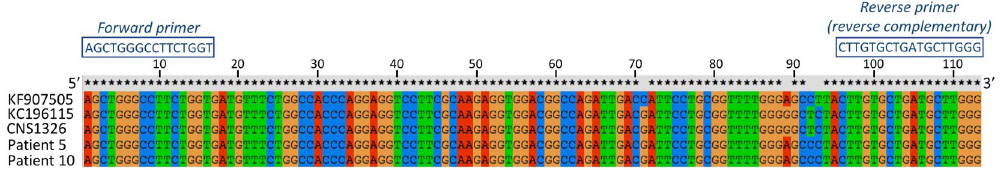
Figure 1. Sequences of the amplicons obtained by NS2A JEV RT-qPCR from throat swabs of patients 5 and 10. Sequences obtained for the 2 patients were aligned (using ClustalX 2.1) with the corresponding sequences of all JEV strains ever handled in the laboratory. KF907505: JEV RNA used as positive control for all JEV RT-qPCR runs. KC196115 and CNS1326: the two JEV strains isolated on cell culture from CSF patients in 2009 and 2013 respectively. Sequence identities are indicated by stars. Sequences of the forward and reverse primers used for the JEV RT-qPCR are indicated above the sequence